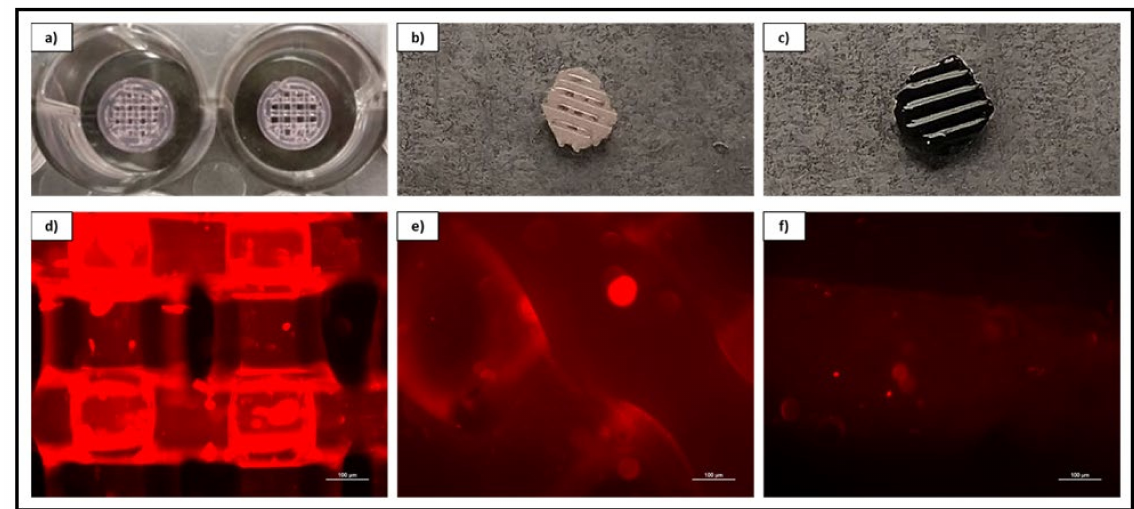
Figure 6. Overview and magnified (10 × ) fluorescent imaging of acellular 40% w / v PF-127 bio-ink containing ECM derived from rDPSC-R as a standalone printed lattice structure ( a – d ) and coating both a PCL ( b – e ) and rGO-PCL ( c – f )